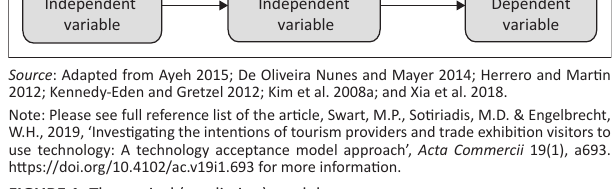
FIGURE 1: Theoretical (prediction)